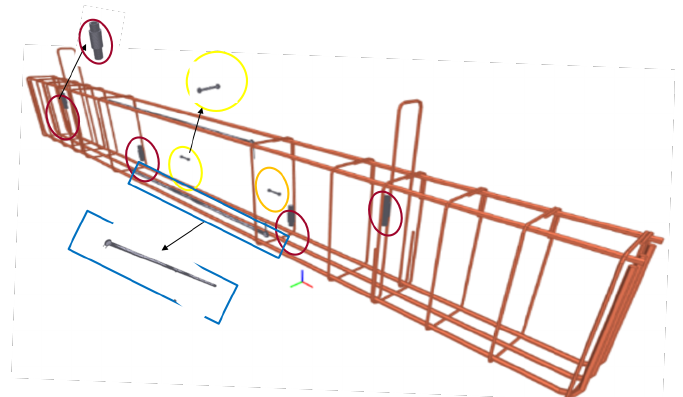
Figure 4. 3D view of the beam reinforcement with sensors location.